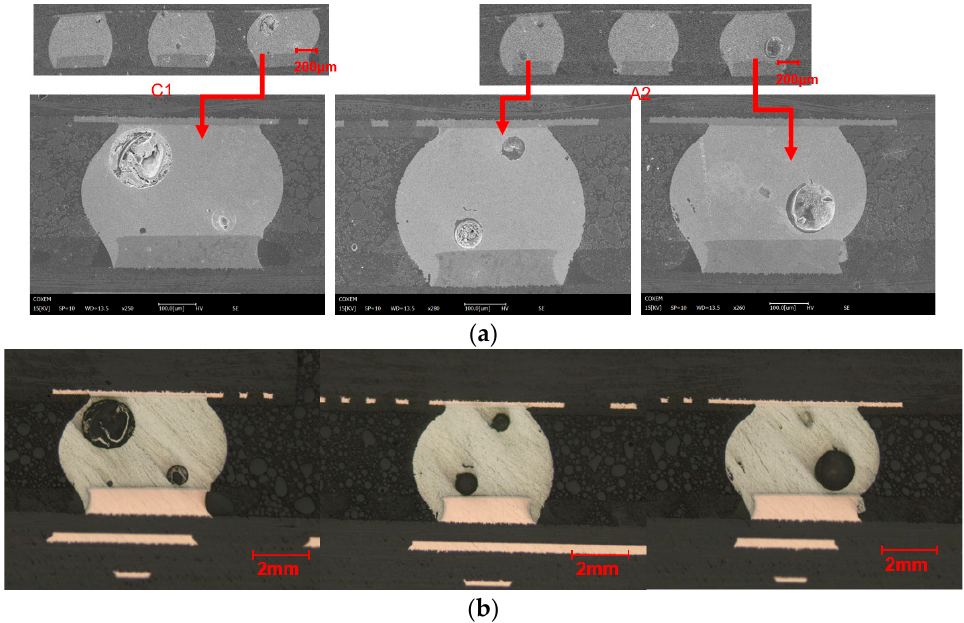
Figure 10. Diagonal cross-sectional ( a ) SEM and ( b ) metallographic microscope images of the solder joints after thermal shocks. joints after thermal shocks.